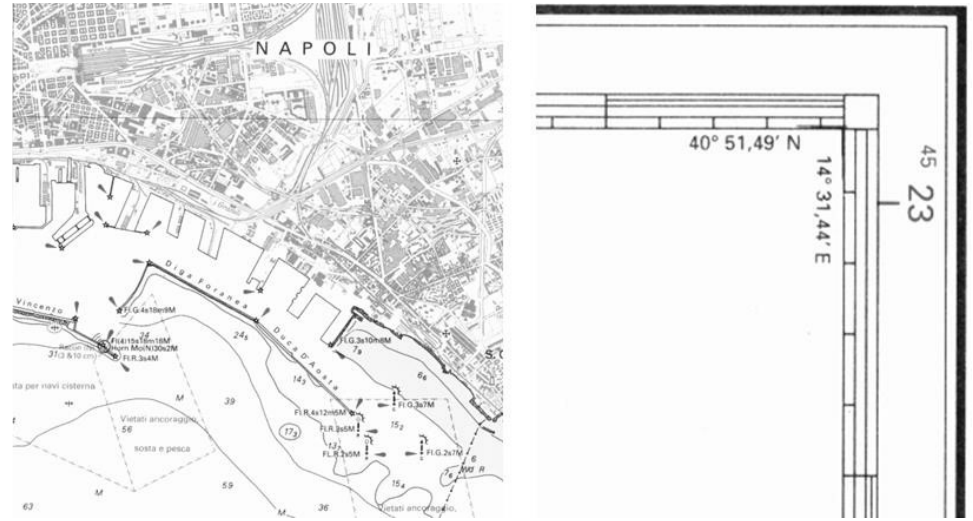
Figure 4. Details of the Nautical Chart n° 130 produced by IIMM: zoom on the East part of the Port of Naples (on the left) and zoom on the upper right corner reporting the ED50 ellipsoidal coordinates (on the right).